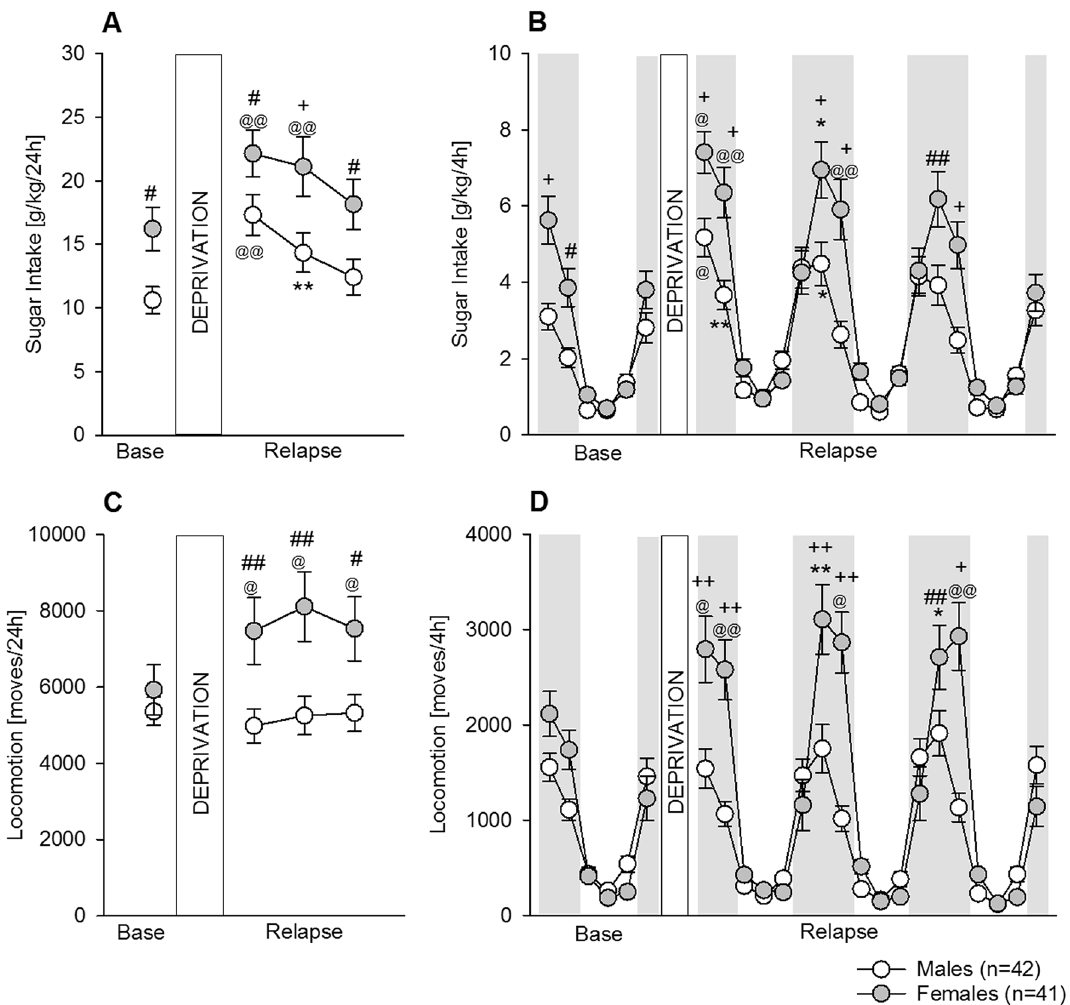
Figure 5. Characterization of the sugar deprivation effect (SDE) in male and female mice (Experiment 2b). ( A ) A period of sugar deprivation significantly increased the sugar intake in both male (white circles, n = 42) and female (grey circles, n = 41) mice , indicative of a sugar deprivation effect (SDE), which lasted 2 days, and was higher in females. ( B ) During the first day, dissection of the SDE into 4 h intervals showed that intake was strongly pronounced during the first 4 h of sugar re-exposure and lasted for 8 h in both males and females. During the second day, the SDE was stronger in females compared to males, as it lasted for 8 h, while in males it was attenuated in respect to the first day and lasted only 4 h. ( C ) Females (but not males) showed a very pronounced increase in locomotor activity which lasted 3 days. ( D ) Dissection of the locomotor activity into 4 h intervals showed that it was strongly pronounced during the first 4 h of sugar re-exposure and lasted not longer than 8 h in females. All data represent means ± SEM. (#, ##, + , + +) indicate P < 0.05; 0.01; 0.005; 0.001 vs male mice; respectively; (*, **, @,@@) indicate P < 0.05; 0.01; 0.005; 0.001 vs corresponding baseline point,